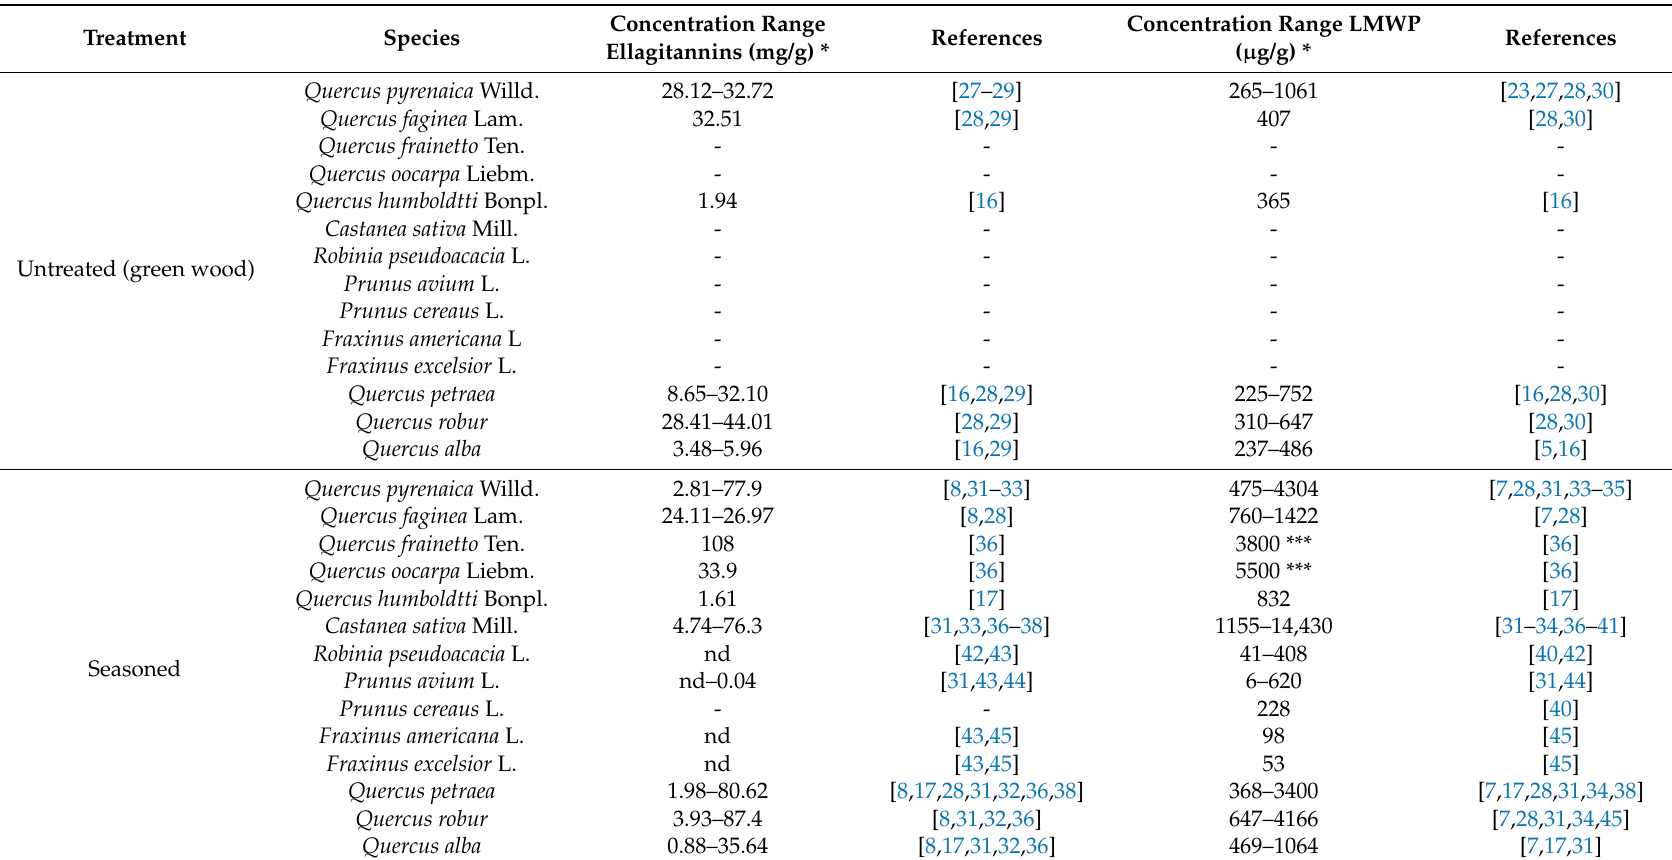
Table 1. The range of ellagitannins and low molecular weight phenolic (LMWP) compounds found in green, seasoned, and toasted wood. * sum of castalagin, vescalagin, granidin, and A, B, C, D, and E roburins; ** sum of acids (ellagic, gallic, syringic, vanillic, and ferulic), aldehydes (coniferaldehyde, sinapaldehyde, syringaldehyde, and vanillin) and cumarins (scopoletin and aesculetin); *** sum of gallic acid and elagic acids.